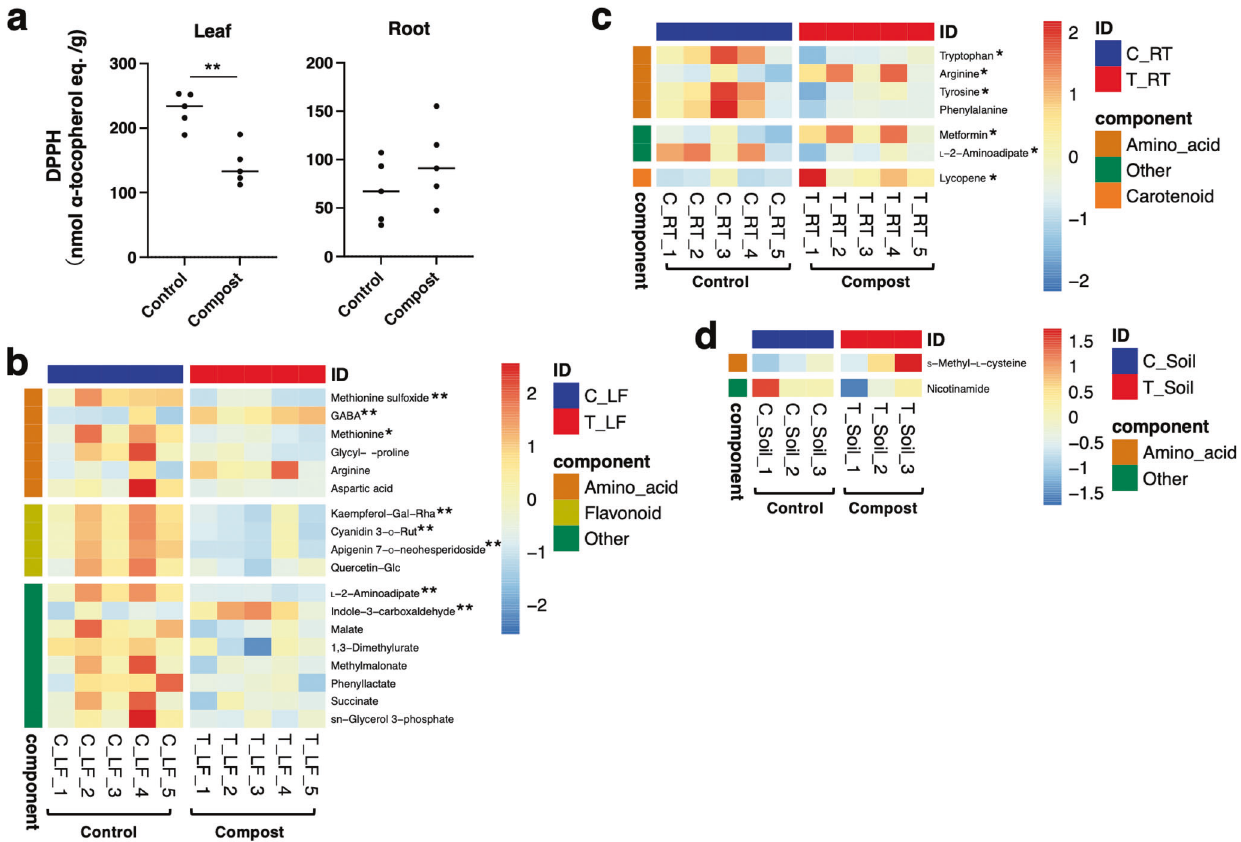
Fig. 3 The antioxidant activity in the leaves and roots of carrots and heatmaps of correlation between the categories belonging to metabolite candidates. a DPPH (2,2-diphenyl-1-picrylhydrazyl) activities in the leaf and root of the carrot ( n = 5). “ Control ” and “ Compost ” show the data under normal conditions (control group) and compost-amended conditions (compost group), respectively. b – d Metabolic differences in the leaf, root, and soil. Heatmaps show the relative abundances of the metabolites in each cluster: the control (blue) and test groups (compost-amended group) (red). The representative metabolites in the leaf and the root in each group are shown (comparison of the categories belonging to metabolites with p < 0.1 as signi fi cant values). The metabolites in the soil are shown (comparison of the categories belonging to metabolites with p < 0.2 as signi fi cant values). Signi fi cant values were shown as follows: * p < 0.05; and ** p <